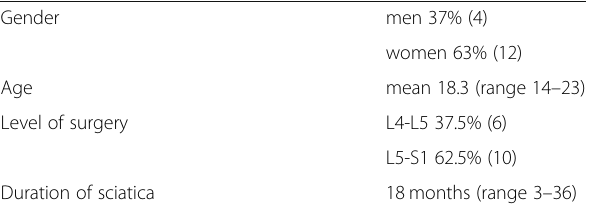
Table 1 Study population demographic data. Percentage